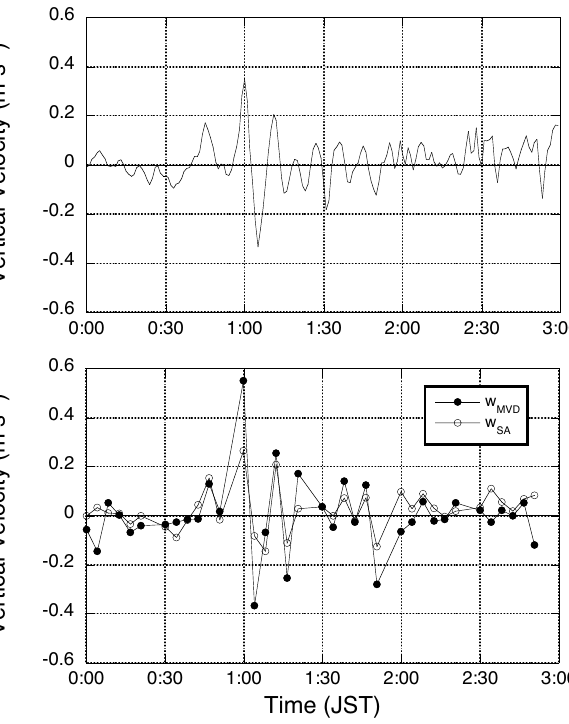
Fig. 7. Time series of vertical air motion derived from the tower and the profiler at 200m from 00:00 to 03:00 JST on 30 December 1997. The top panel contains the vertical velocity recorded with the tower-mounted sonic anemometer, smoothed with a 2-minute running mean. The bottom panel contains the vertical velocities obtained from the profiler using the MVD method (closed circles) and from the sonic anemometer (open circles) averaged over the duration for the MVD method. The profiler data have been shifted in time to account for the fact that the gravity current arrived there earlier than at the